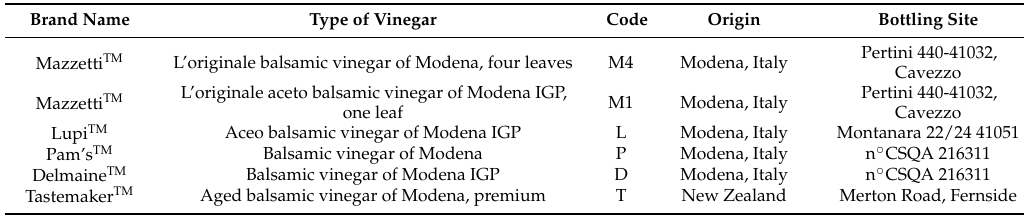
Table 3. The commercial balsamic vinegars analyzed, and their origins.